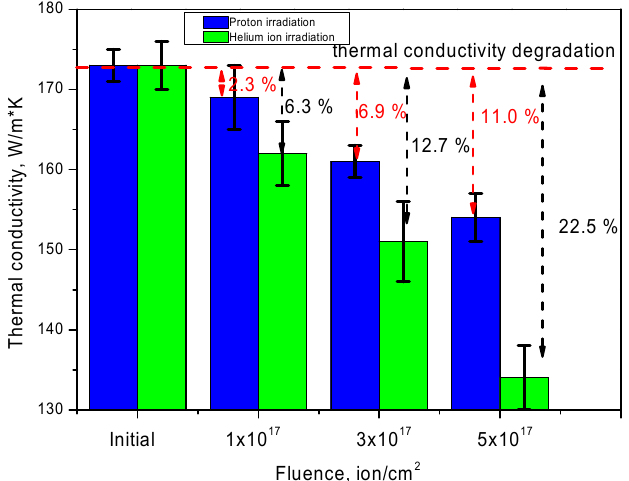
Figure 5. Diagram of the dependence of the coe ffi cient of thermal conductivity on the dose and type of exposure.